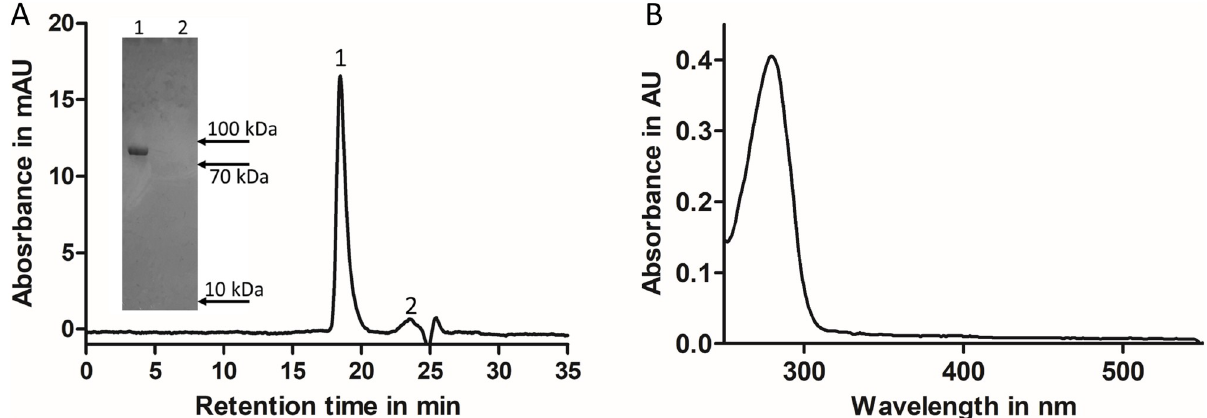
Fig 3. Analytical size exclusion and UV-vis spectrum of purified native DPP3. (A) Analytical Size Exclusion Chromatogram of native hDPP3. DPP3 purified via IAP and IEX was applied on a Shodex silica gel-size exclusion column with a flowrate of 0.5 mL/min. Fractions belonging to peaks 1 and 2 were collected and analyzed via SDS-PAGE (inlay). (B) UV-vis spectrum of purified native DPP3 in the range of 250-550nm. The spectrum was recorded in storage buffer at room temperature using DPP3 in a concentration of 324 μ g/mL.